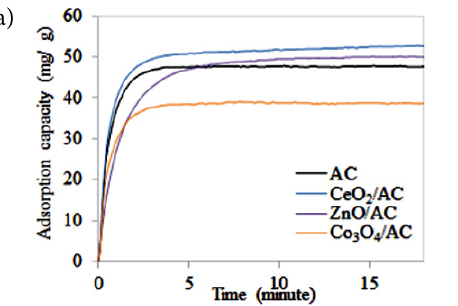
Figure 6. a) CO 2 adsorption at 30 °C and b) desorption process until 400 °C.